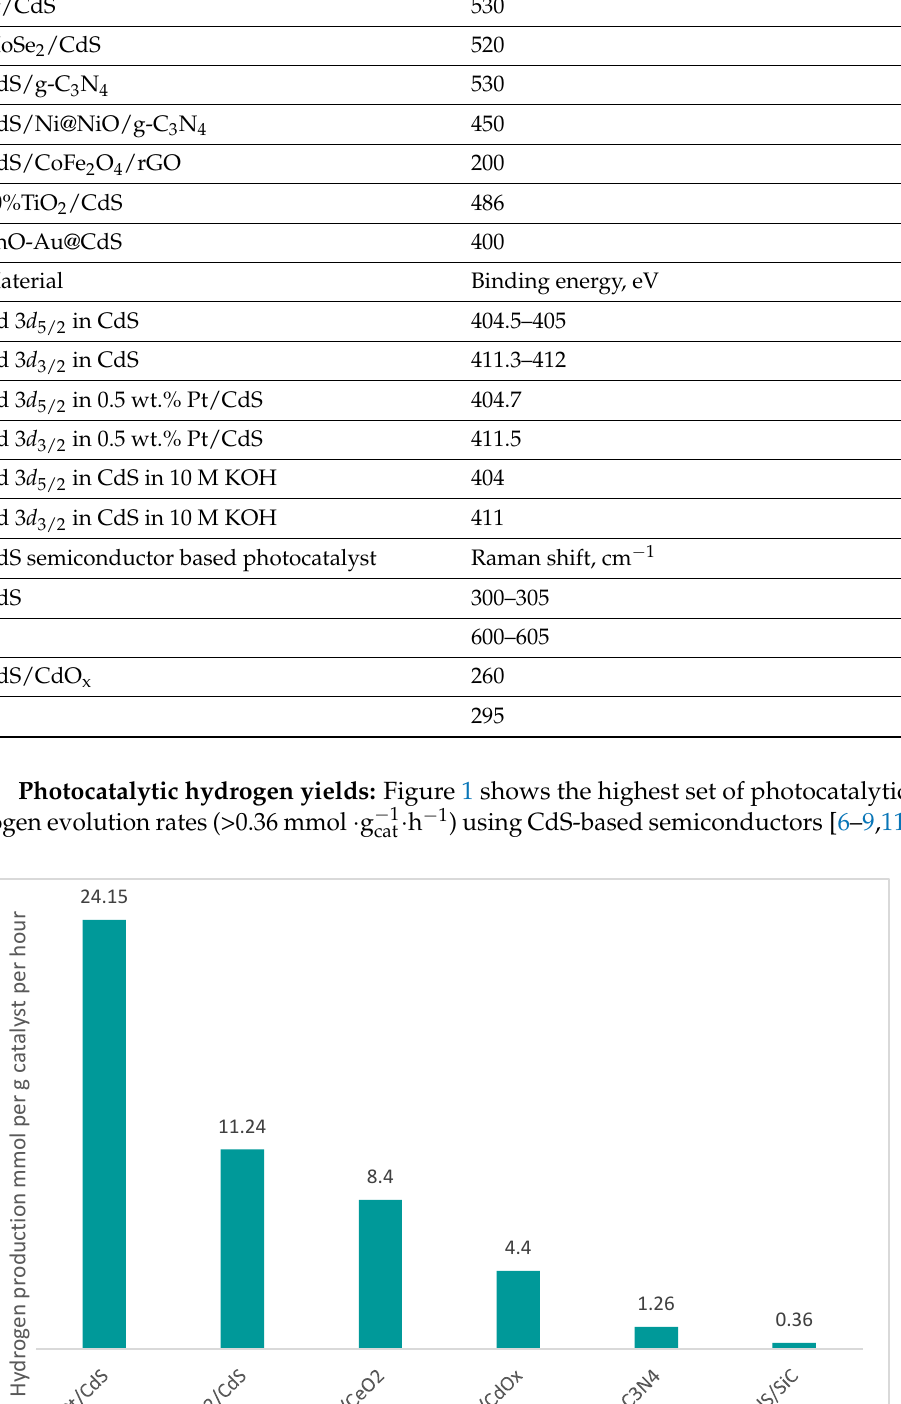
Table 2. CdS-based photocatalytic system analytical characteristics.